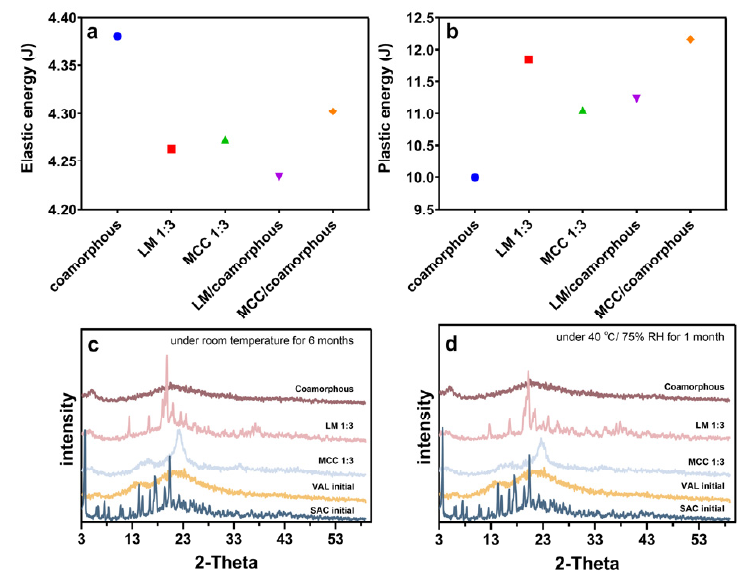
Figure 7. Elastic work ( a ) and plastic work ( b ) in joules on co-amorphous and co-amorphous LM or MCC SDs at a 1:3 weight ratio and binary mixture of co-amorphous and inert carriers at corresponding weight ratios. Powder X-ray diffraction (PXRD) patterns of spray-dried preparations ( c ) under room temperature for 6 months, ( d ) under 40 °C/75% RH for 1 month.